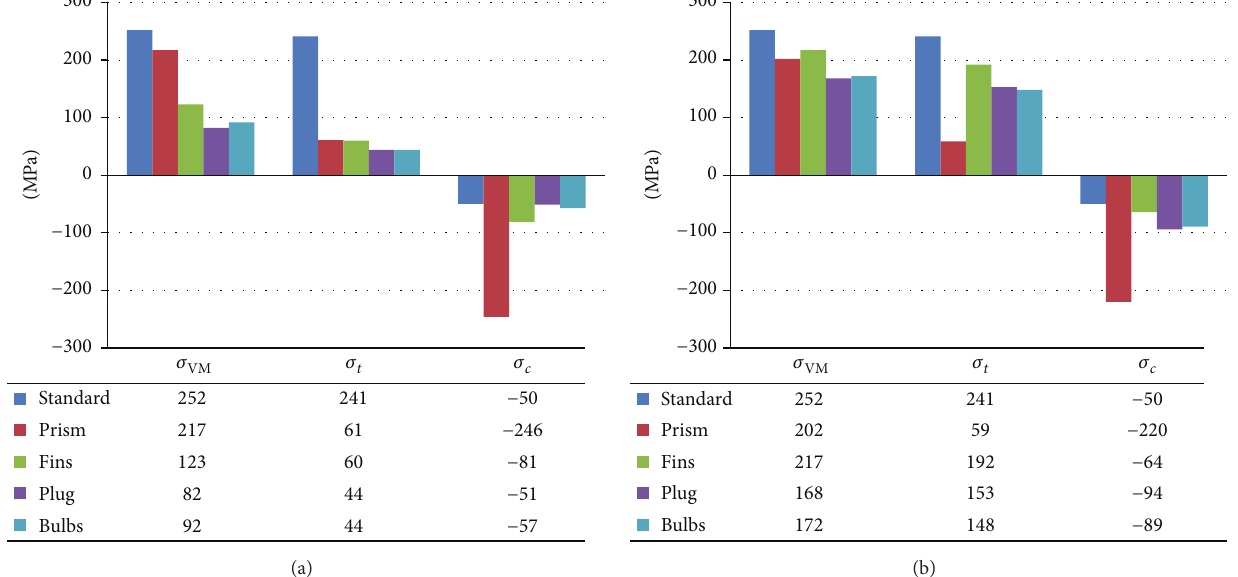
Figure 4: Comparison of the maximum von Mises equivalent stress ( 𝜎 VM ) and the tensile ( 𝜎 𝑡 ) and compressive ( 𝜎 𝑐 ) principal stresses under vertical (a) and oblique (b) loading components in the 5